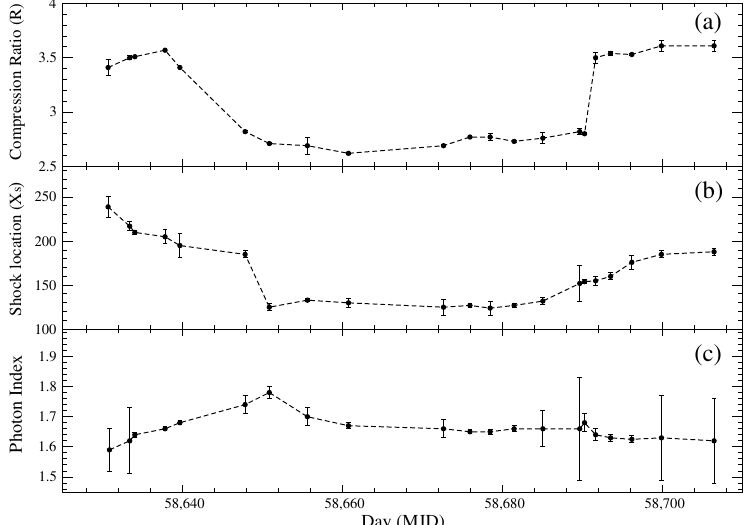
Figure 8. Variation of TCAF model-fitted ( a ) compression ratio (R), ( b ) shock location ( X s ) and ( c ) powerlaw model-fitted photon index ( Γ